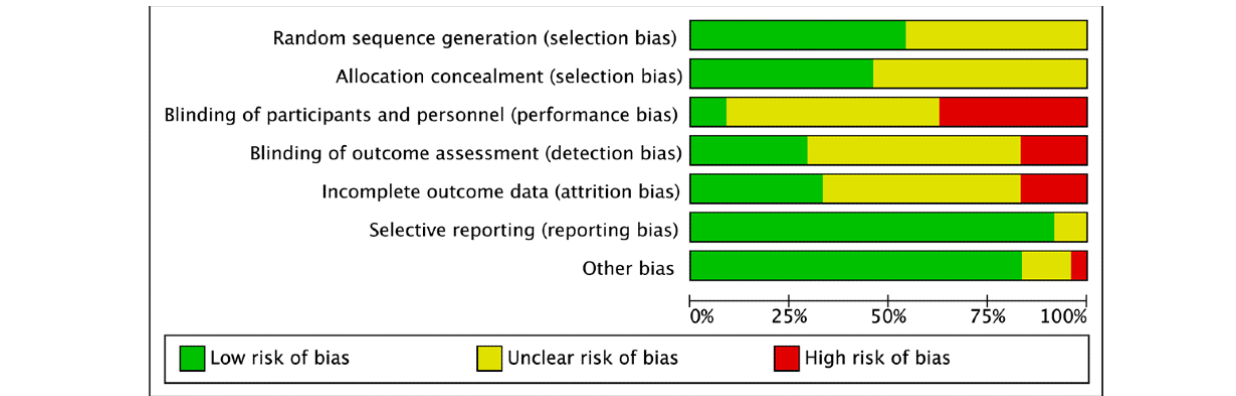
Figure 5. Results of the risk of bias